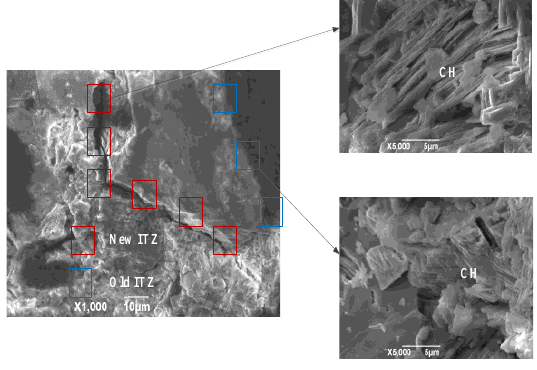
Figure 9. Images showing ITZs in RAC.